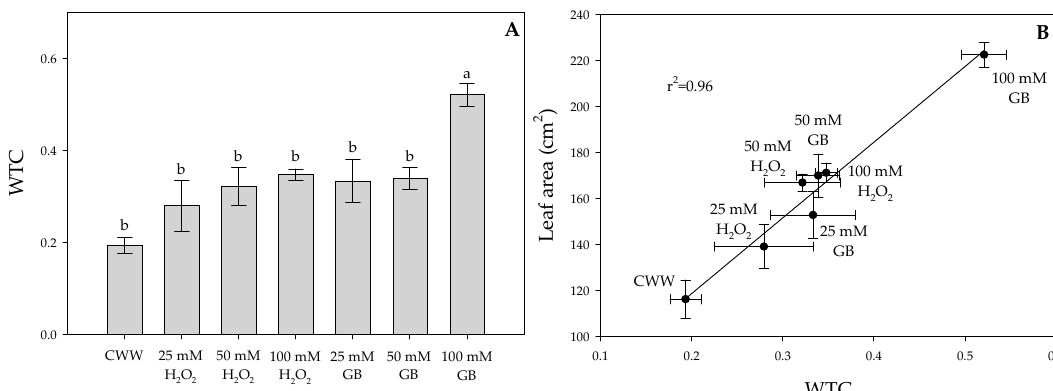
Figure 1. ( A ) Waterlogging Tolerance Coefficient (WTC) at 13 Days After Waterlogging (DAW) and ( B ) correlation between the leaf area and the WTC of Cape gooseberry ( Physalis peruviana L.) plants ecotype Colombia subjected to a waterlogging period with treatments of control with waterlogging (CWW), 25 mM of hydrogen peroxide (H 2 O 2 ), 50 mM of hydrogen peroxide (H 2 O 2 ), 100 mM of hydrogen peroxide (H 2 O 2 ), 25 mM of glycine betaine (GB), 50 mM of glycine betaine (GB) and 100 mM of glycine betaine (GB). Evaluated 13 days after waterlogging (DAW). Data represent the average of ten plants ± standard error per treatment ( n = 5). Bars followed by di ff erent letters indicate statistically significant differences according to the Tukey test ( p ≤ 0.05).